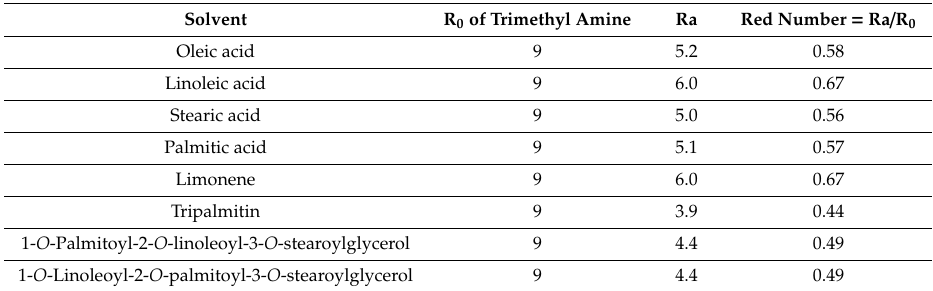
Table 7. Relative energy di ff erence (RED) of trimethylamine for each vegetable oil.